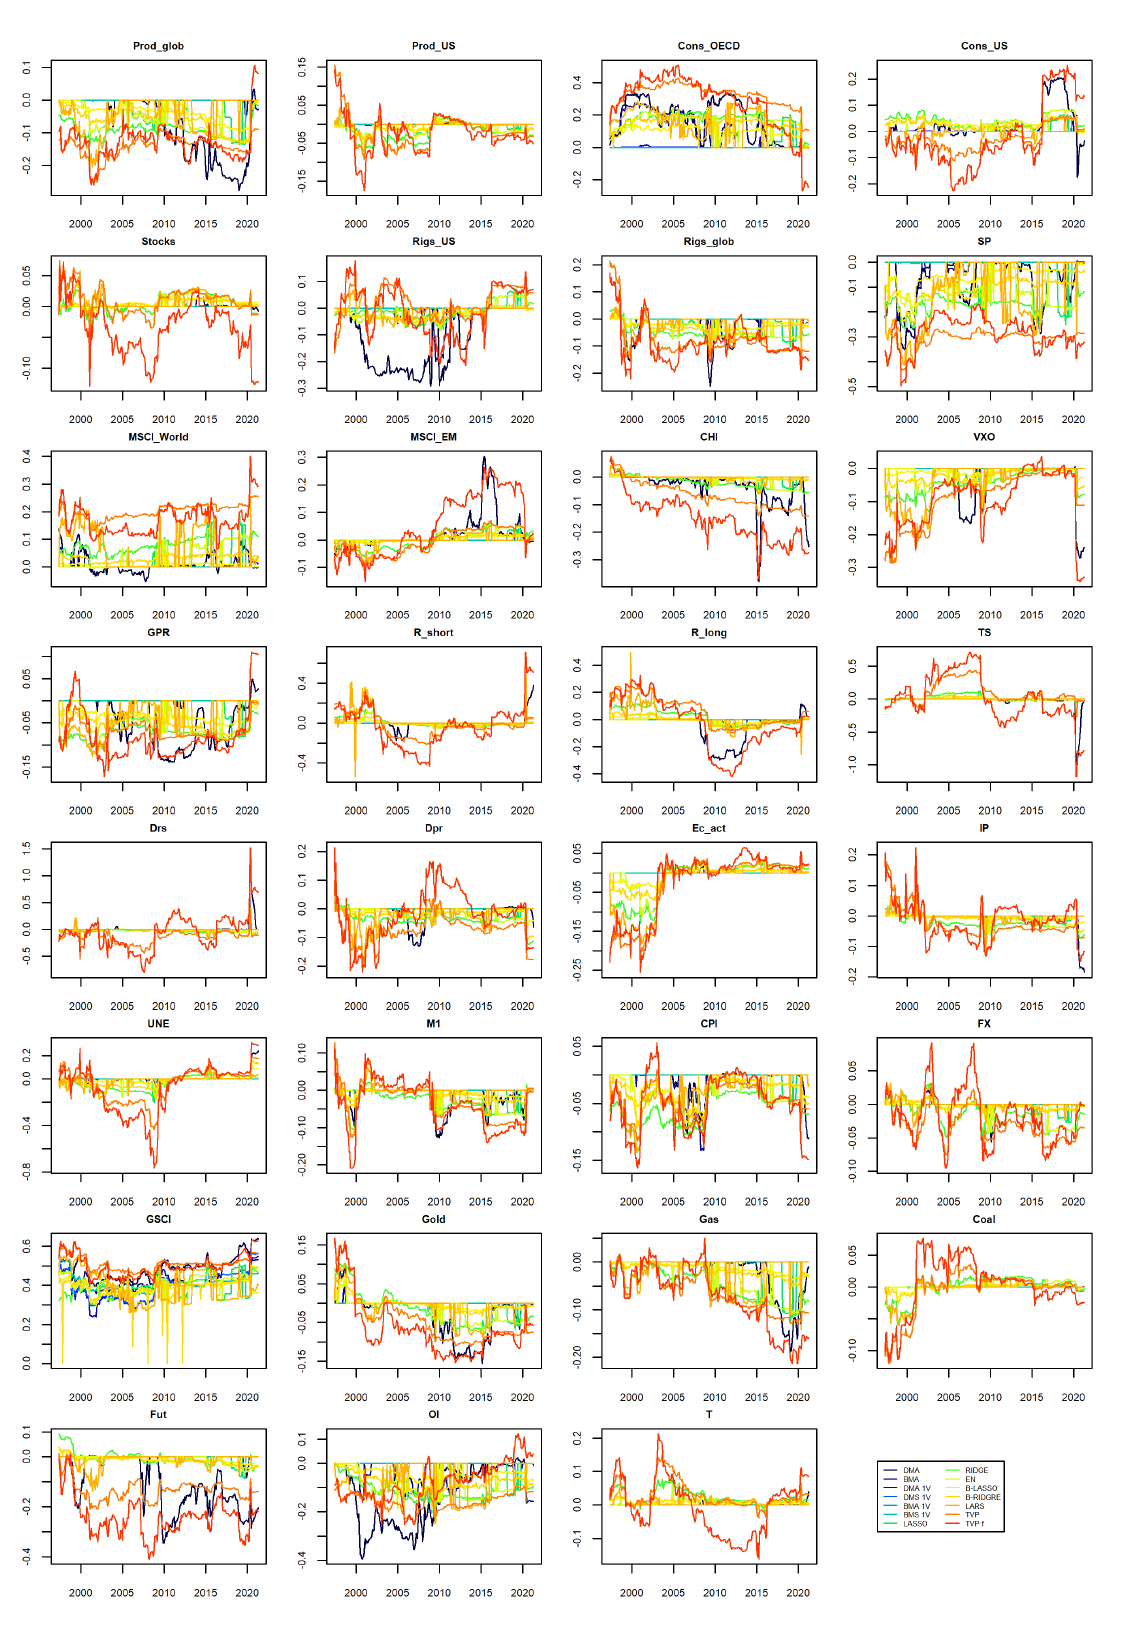
Figure 2. Weighted average coefficients from suitable model combination schemes.